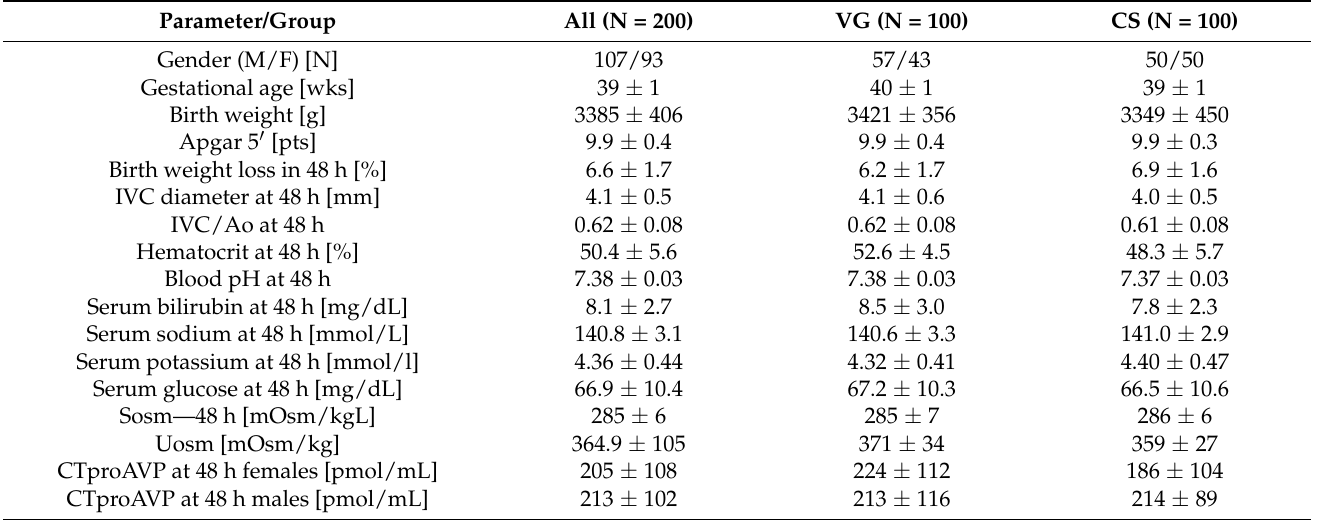
Table 1. Characteristics of all enrolled patients, divided into two subgroups dependent of the mode of delivery (VG—vaginal delivery; CS—cesarean section, Sosm—effective serum osmolality, Uosm—urine osmolality). Mean and ± SD are